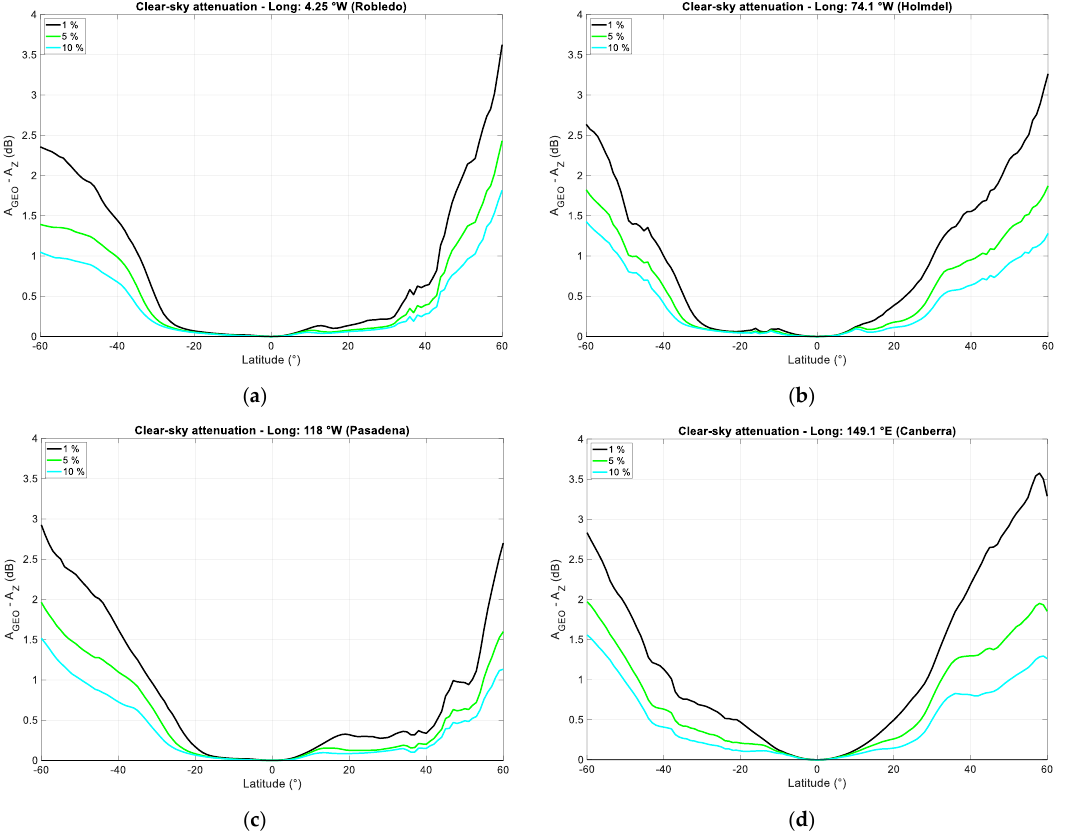
Figure 14. The difference 𝐴 𝐺𝐸𝑂 − 𝐴 𝑍 , calculated at annual probabilities 1%, 5%, and 10%, between the clear-sky attenuation exceeded in the GEO path, 𝐴 𝐺𝐸𝑂 , and that exceeded in the GeoSurf path, 𝐴 𝑍 , along the meridian of: (a) Robledo (GEO elevation angle 42.8°), (b) Holmdel (GEO elevation angle 43.3°), (c) Pasadena (GEO elevation angle 50.3°), and (d) Canberra (GEO elevation angle 49.0°), in the latitude range 60°N to 60°S.